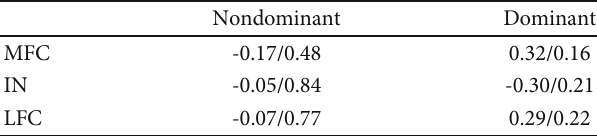
Figure 3: Comparisons of sti ff ness between speci fi c regions of distal FAC. ∗ means a signi fi cant di ff erence. Table 3: Di ff erences in the sti ff ness and thickness of FAC between Table 4: Relationship between thickness and sti ff dominant and nondominant sides.